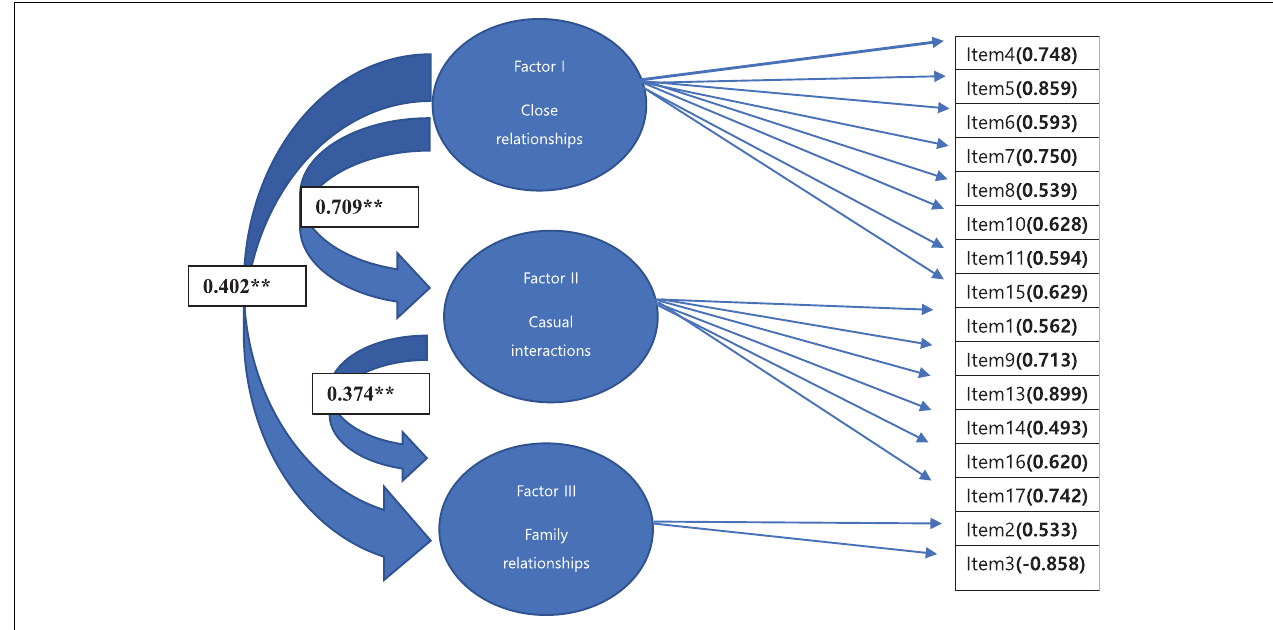
FIGURE 1 | Three-factor model for the Korean translated ACIPS. ** p <